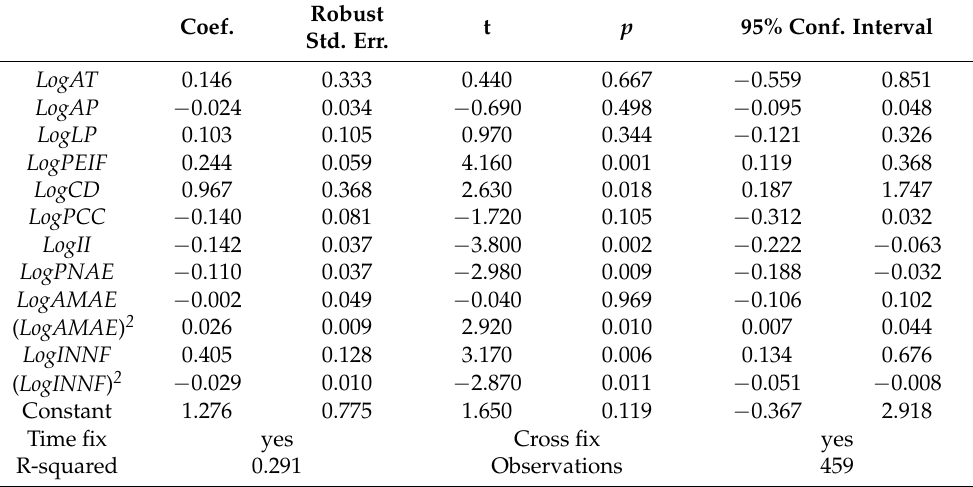
Table A1. Robustness